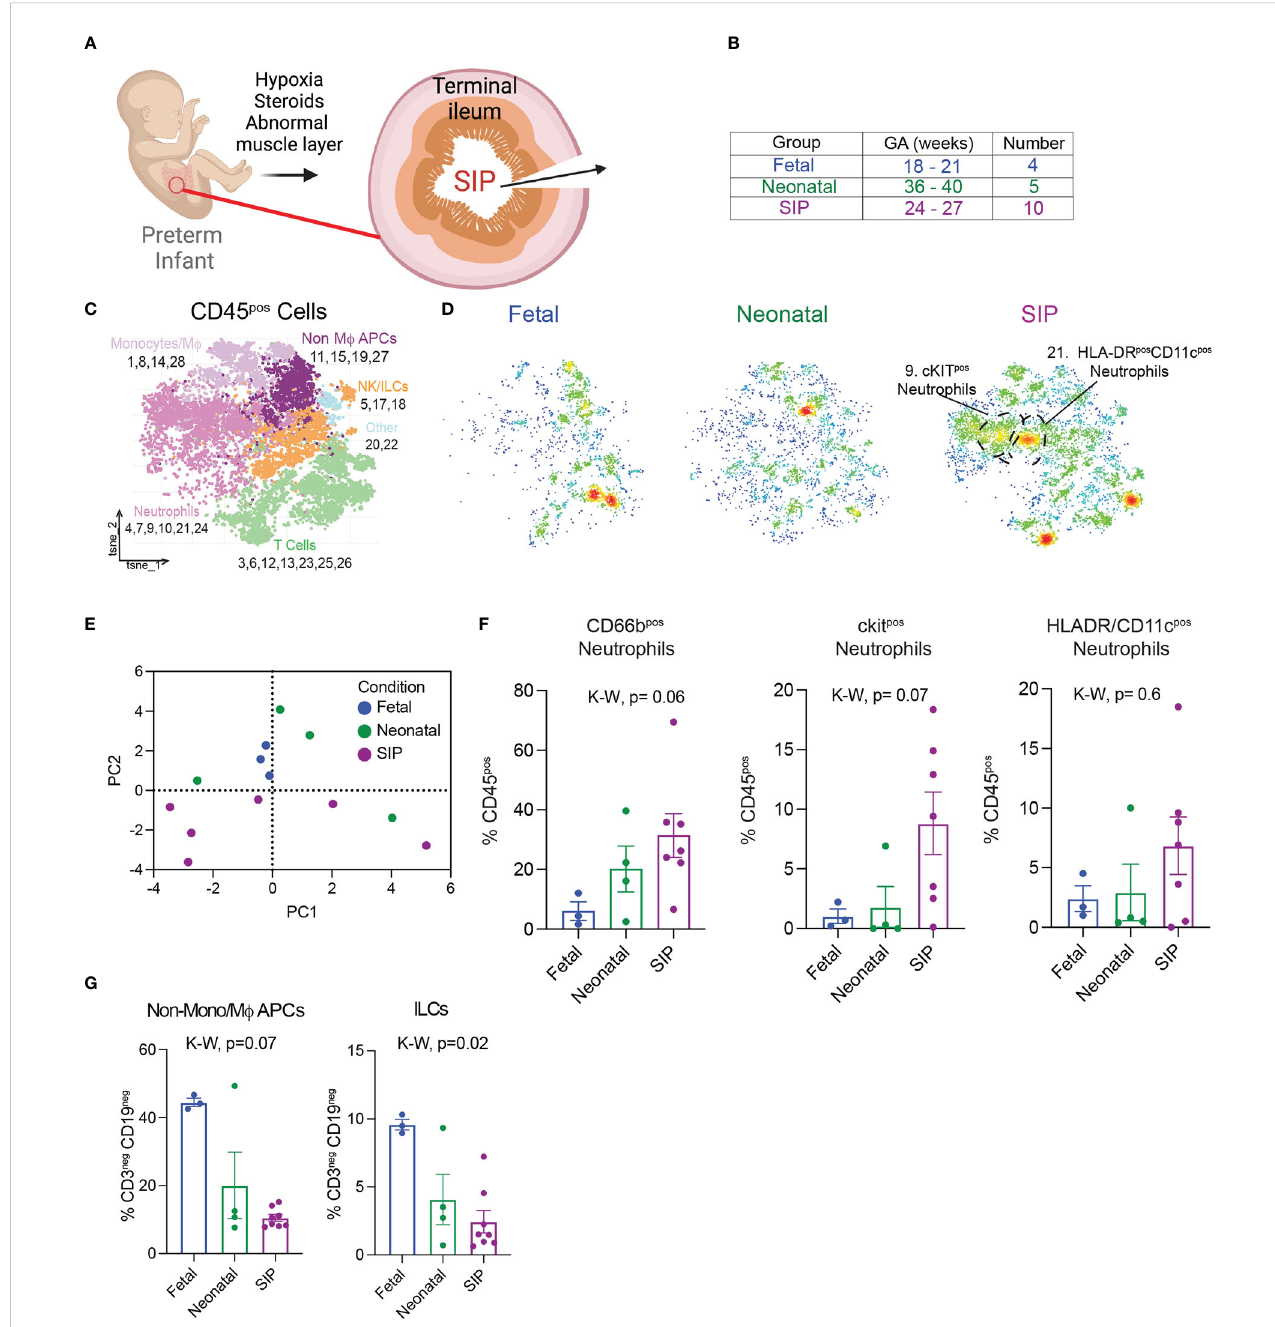
FIGURE 1 Immune landscape in neonatal spontaneous intestinal perforation (A) Exposures that increase susceptibility to SIP. (B) Samples analyzed using suspension mass cytometry (CyTOF) listed with gestational age (GA) detailed in Table 1. (C). t-stochastic neighborhood embedding (tSNE) of all leukocytes (CD45 + ) exported from Premium Cytobank after manual gating (Figure S1A). Populations were de fi ned using canonical markers outlined in Figure S1B. (D) Density plots of samples in each group, fetal n=3, neonatal n=4, SIP n=8. (E) Principal component analysis plot based on CD45 + populations in C generated with GraphPad ® Prism 9 (Methods). (F) All, ckit + , HLADR/CD11c + neutrophils expressed as a percentage of all CD45 + cells. (G) Non-mono/M f APCs and ILCs expressed as a percentage of innate cells (CD3 - CD19 - ). Each dot represents 1 case (fetal n=3, neonatal n=4, SIP n=7). Non-M f APCS – non-macrophage antigen presenting cells. NK/ILCs – natural killer/innate lymphoid cells. p-value, K-W Kruskal-Wallis test